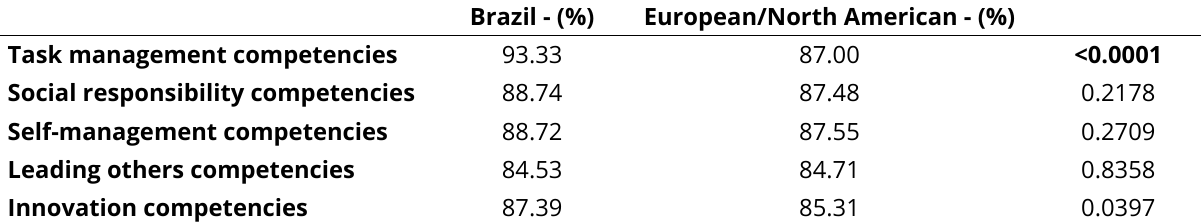
Table 2. Percentage of responses ≥4 for each group.